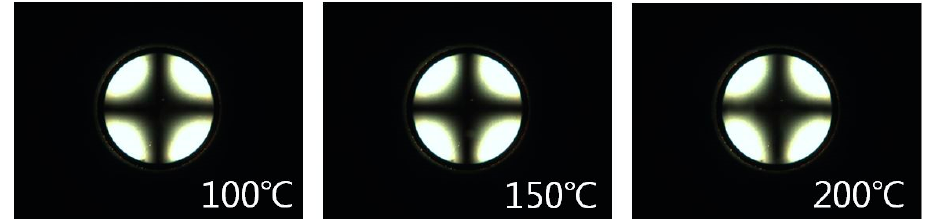
Figure 7. Conoscopic POM images of PEUG100 LC cells, after heat treatment at 100, 150, and 200 °C for 10 min, respectively.